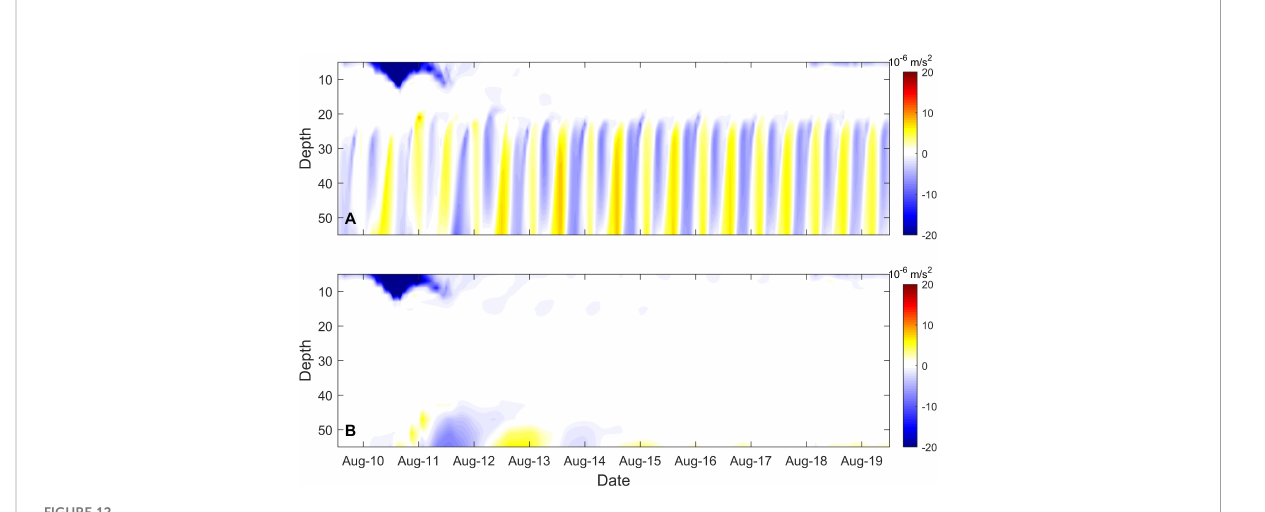
FIGURE 12 Eddy viscosity (m/s 2 ) at the mooring site (A) with and (B) without